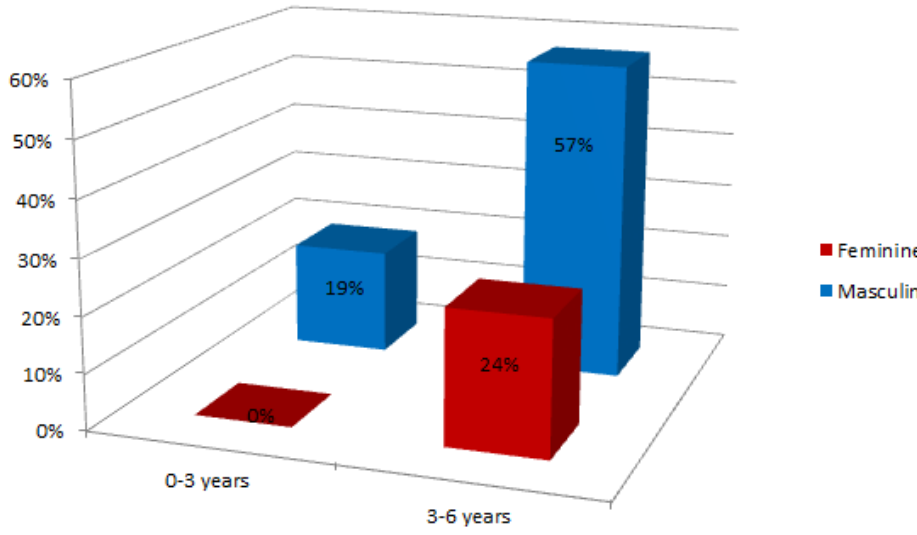
Figure 15. Language results in each stage of growth by